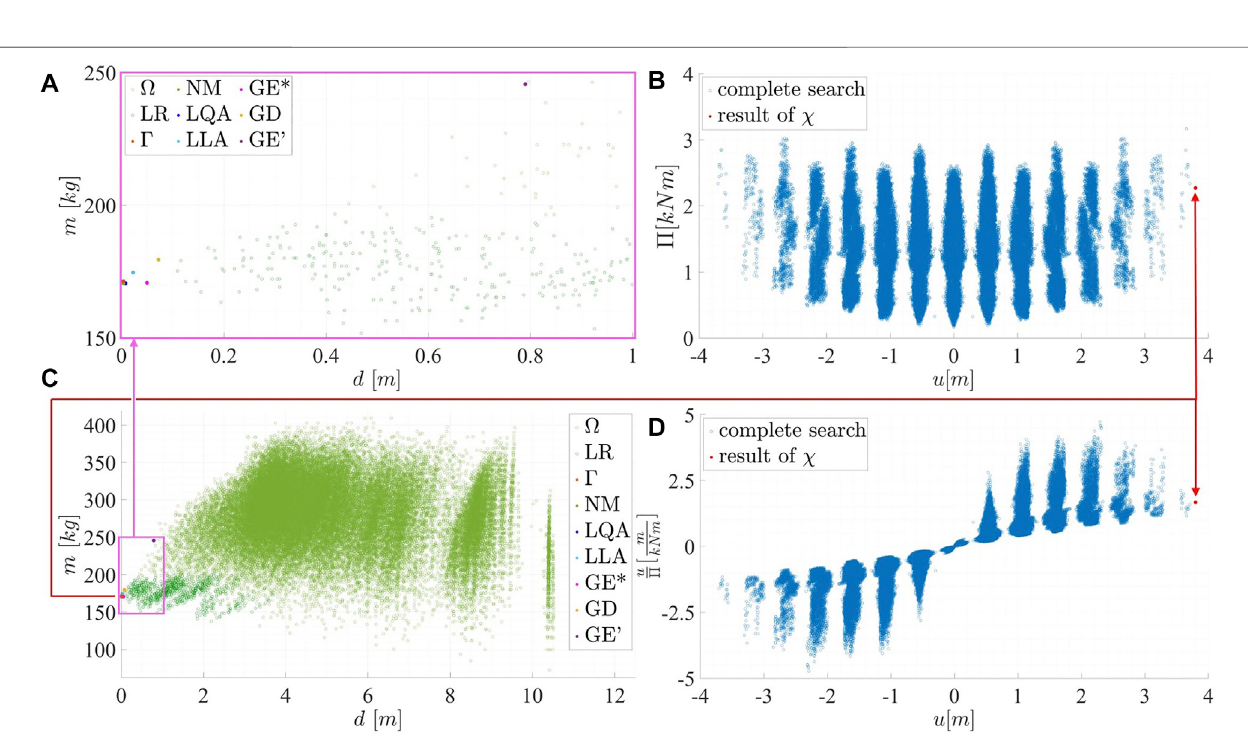
FIGURE9|(A) and (C) Comparisonandvalidationoftheresultsofthestructuraloptimizationsusingdifferentalgorithms( Table2 )for β 0 =(2.52.52.52.52.52.5) T ; (B) and (D) χ — optimal actuator placement, with the results of the respective complete enumerations (all structural variants Ω of the parametric model with local re fi nementLR(greencircles),mass( Eq.6 )overdeformation( Eq.5 )/completesearchfor10compressionand10tensionactuators(bluecircles), (B) energy( Eq.13 )over transformation ( Eq. 12 ), and (D) ) ef fi ciency ( Eq. 18 ) over transformation ( Eq. 12 ).